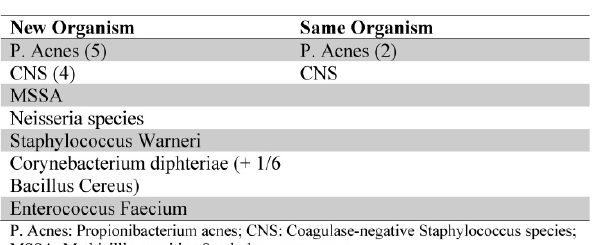
Table 3: Organisms cultured at reimplantion with respect to the index